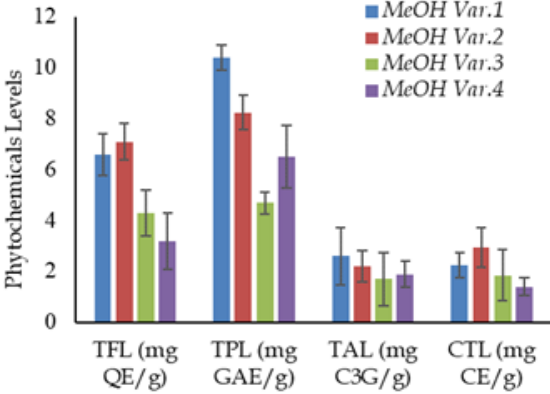
Figure 2. Levels of various phytochemicals of fig flowers fruits methanolic extracts. MeOH Var.1; MeOH Var.2 : Variety 1, 2 Bakor ( Fig flowers) of Bechar. MeOH Var.2; MeOH Var.3 : Variety 2 Bakor of Mascara. TFL: Total Flavonoids Level, TAL: Total Anthocyanins Level, TPL: Total phenolics Level. CTL: Condensed Tannins Level. mg QE/g : quercetin equivalents; mg C3G/g : cyanidin-3-glucoside equivalents; mg GAE /g : acid gallic equivalents; mg CE/g: catechin equivalent